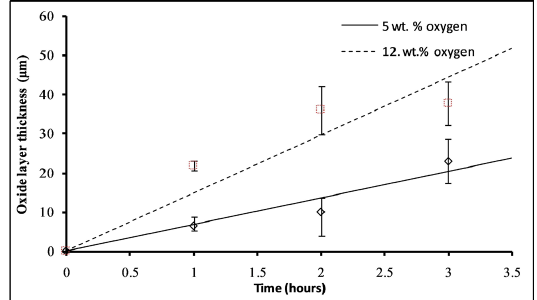
Figure 5. Variation of the oxide layer thickness (μm) with the time (hours) based on the linear model for Cu-32.02% Zn-2.30% Pb alloy that is thermally oxidized in N N -12 wt.% O atmosphere respectively. 2 2